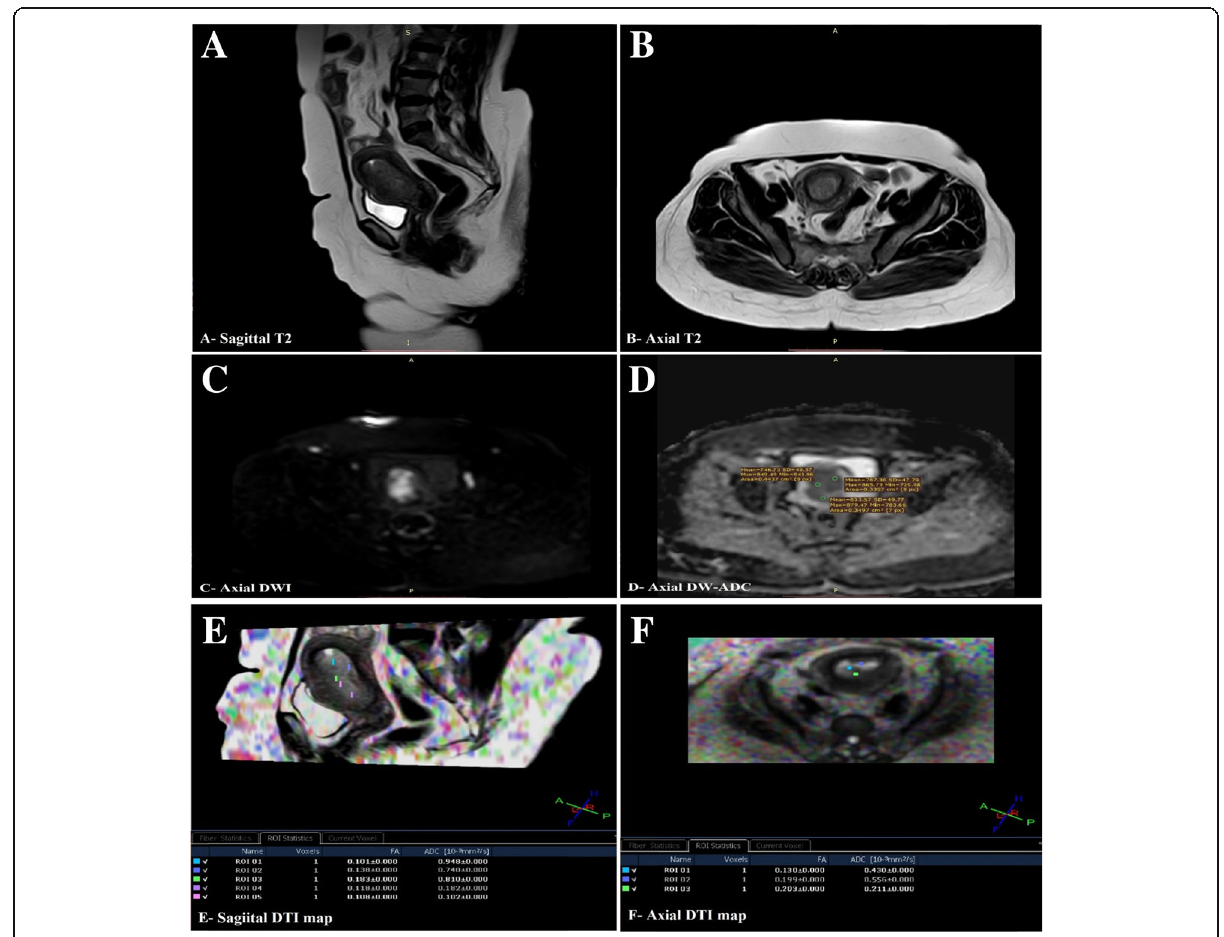
Fig. 6 A 56-year-old postmenopausal female presented by abnormal vaginal bleeding. On TVS examination, there was an ill-defined endometrial polypoid soft-tissue mass of heterogeneous echogenicity measuring about 20 mm in maximum diameter. a, b Sagittal and axial T2 WIs show irregular endometrial soft-tissue mass with ill-defined margins displaying intermediate SI (red stars), distending, and filling the endometrial cavity with poor tumor-to-myometrium interface (blue arrows). The mass also extends to the cervix (yellow arrow). c Axial DWI with b value of 1000 s/ mm 2 shows high SI of the endometrial soft-tissue mass. d Axial DW-ADC map image shows low signal intensity of the endometrial soft-tissue mass. Mean DW-ADC value of the mass = 0.789 × 10 − 3 mm 2 /s. e, f Sagittal and axial DTI map images demonstrate values of DT-FA and DT-MD in multiple ROI. Mean DT-FA and DT-MD values of the endometrial mass = 0.148 and 0.497 × 10 − 3 mm 2 /s respectively. Diagnosis: pathologically proved endometrial clear cell